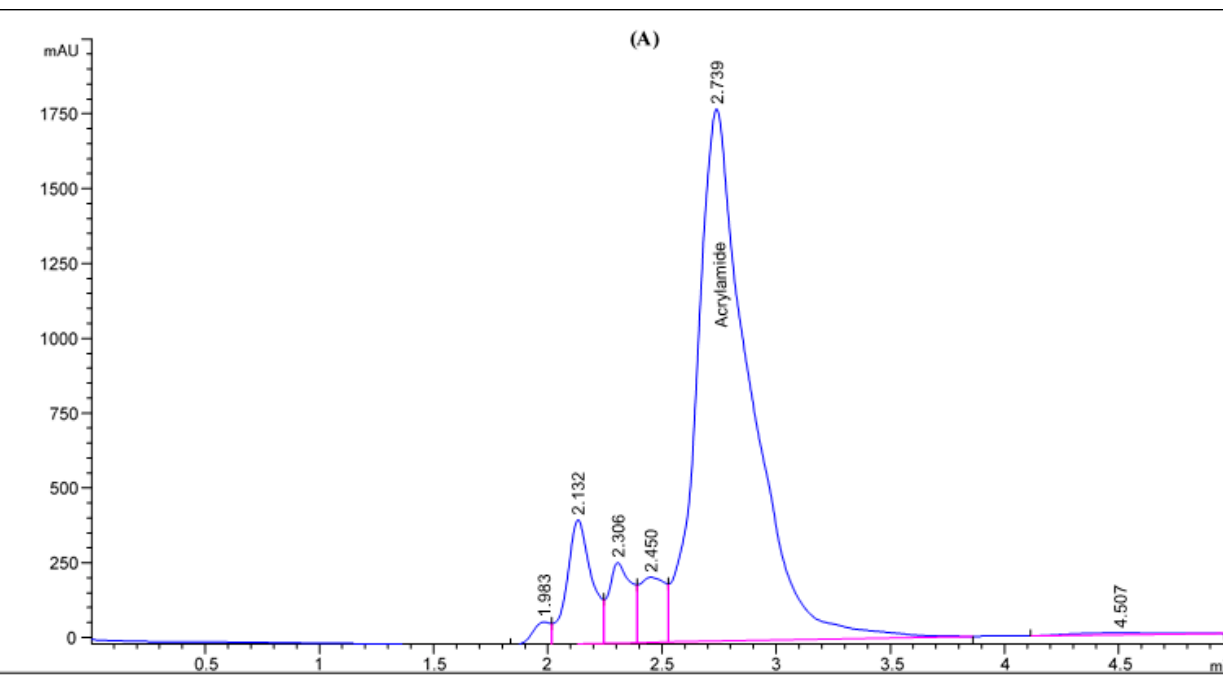
Figure 1. Acrylamide contents and percentage of acrylamide reduction in various fried potato chips treated with different agro-industrial extracts.